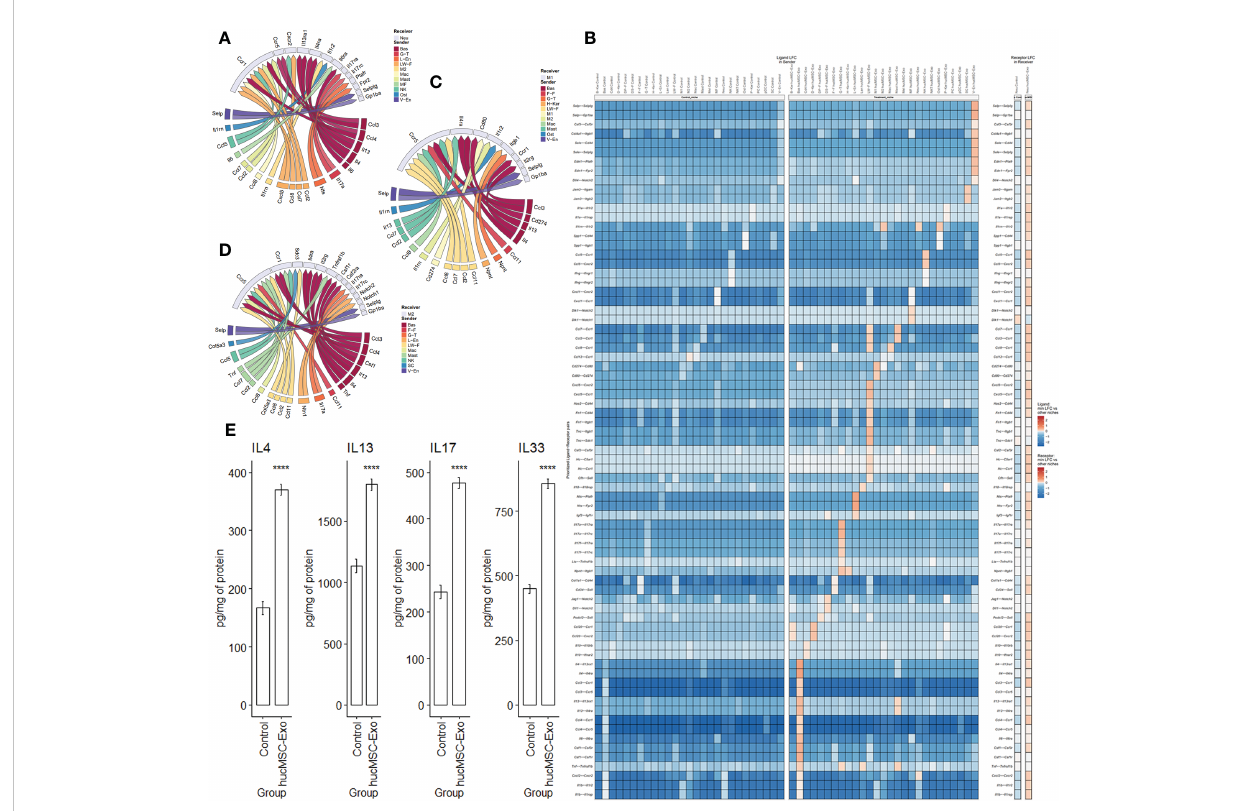
FIGURE 6 Ligand-receptor interactions after hucMSC-Exosomes exposure. (A) Circos plot of differential ligand-receptor interaction for neutrophils (receiver). (B) Heatmap illustrating ligand-receptor expression comparison between the control group and the hucMSC-Exosomes treatment group for neutrophils (receiver). (C) Circos plot of differential ligand-receptor interaction for M1 macrophages (receiver). (D) Circos plot of differential ligand- receptor interaction for M2 macrophages (receiver). (E) Cytokine protein levels for IL-4, IL-13, IL-17 and IL-33 measured by ELISA. Data are presented as mean and standard error. Unpaired two-tail t-test.